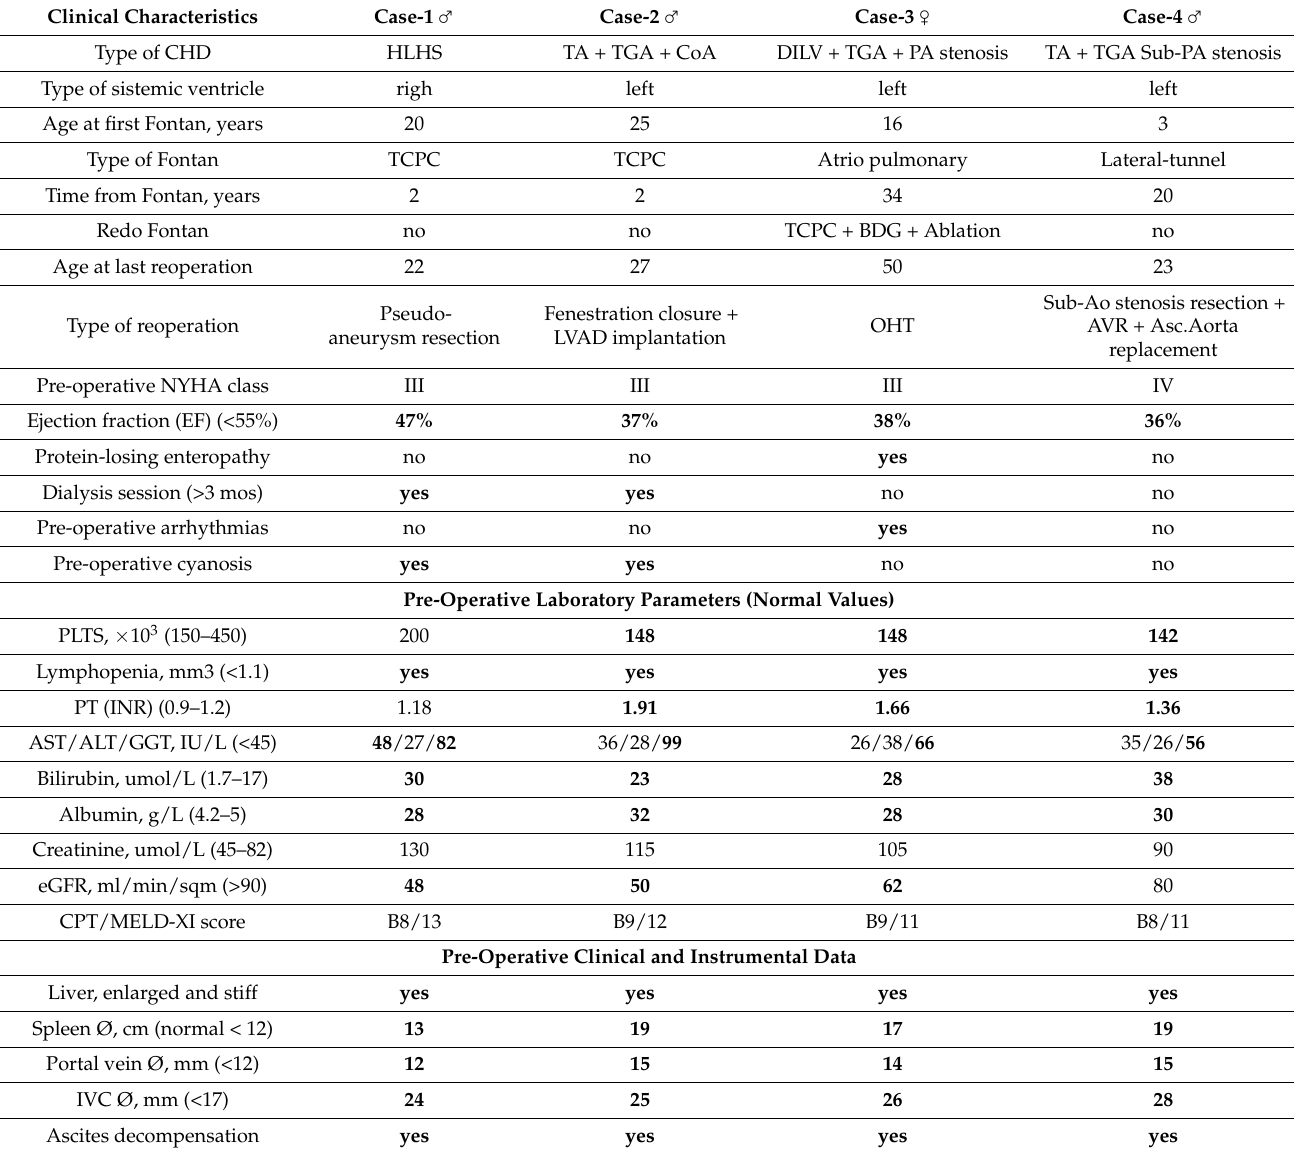
redo-Fontan at 41-years. All cases needed reoperation: one for a pseudo-aneurism resection, one for a LVAD implantation, one for an ascending aorta replacement, and the last case received an orthotopic-heart transplantation (OHT). Table 1. Clinical and laboratory characteristics at the pre-operative presentation of